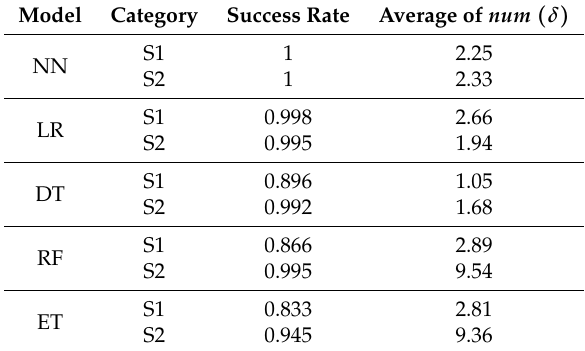
Table 5. The results of our approach.